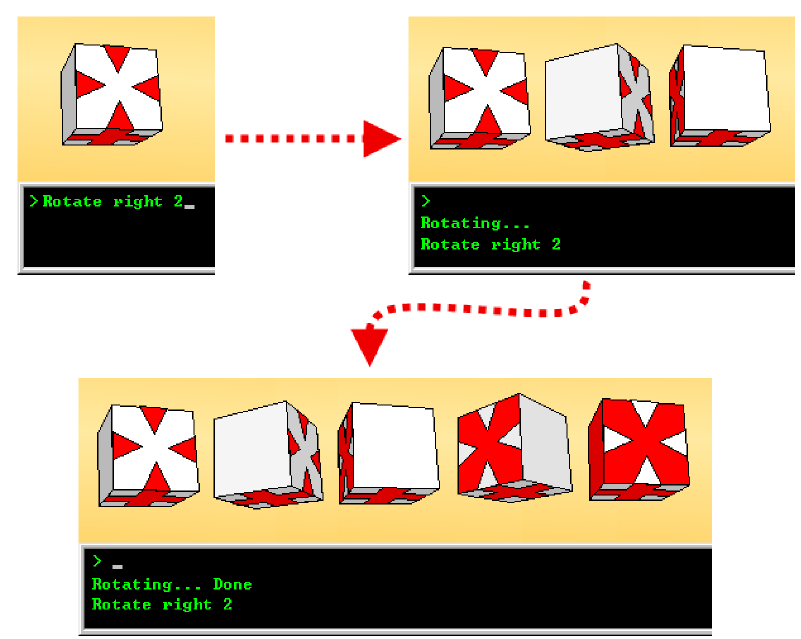
Figure 9. An example of the cube rotating with the stacked type of transition.